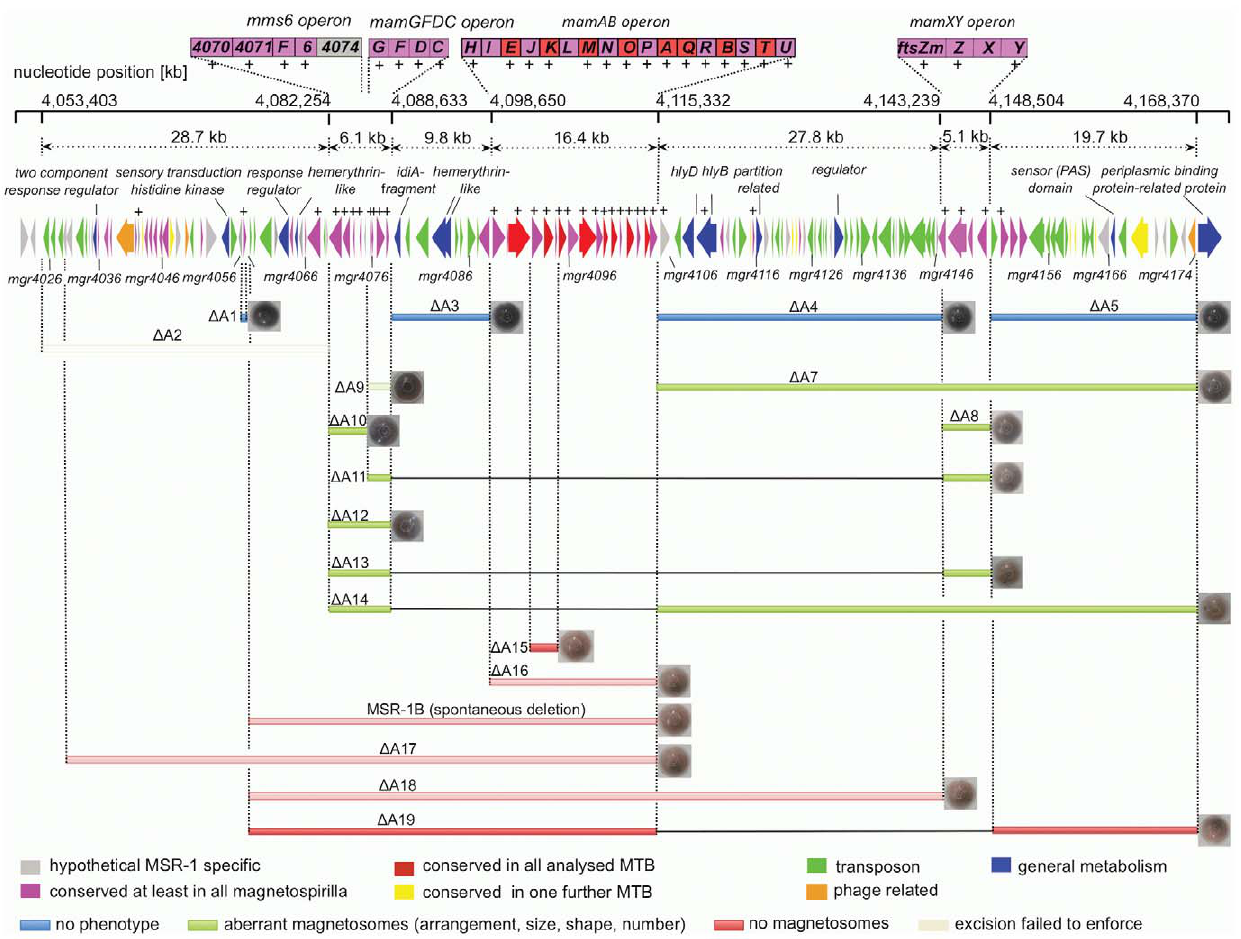
Figure 1. Molecular organization and characteristics of the MAI in M.gryphiswaldense . Extensions of deletions are shown by bars of different colors indicating the general phenotype. For overview, strains generated in previous studies are shown in semi-transparent color. The magnetite content of mutant strains is illustrated by the color of corresponding cell pellet. Degree of gene conservation is highlighted by different colors. Genes found expressed by proteomic analysis are indicated by ‘‘ + ’’.